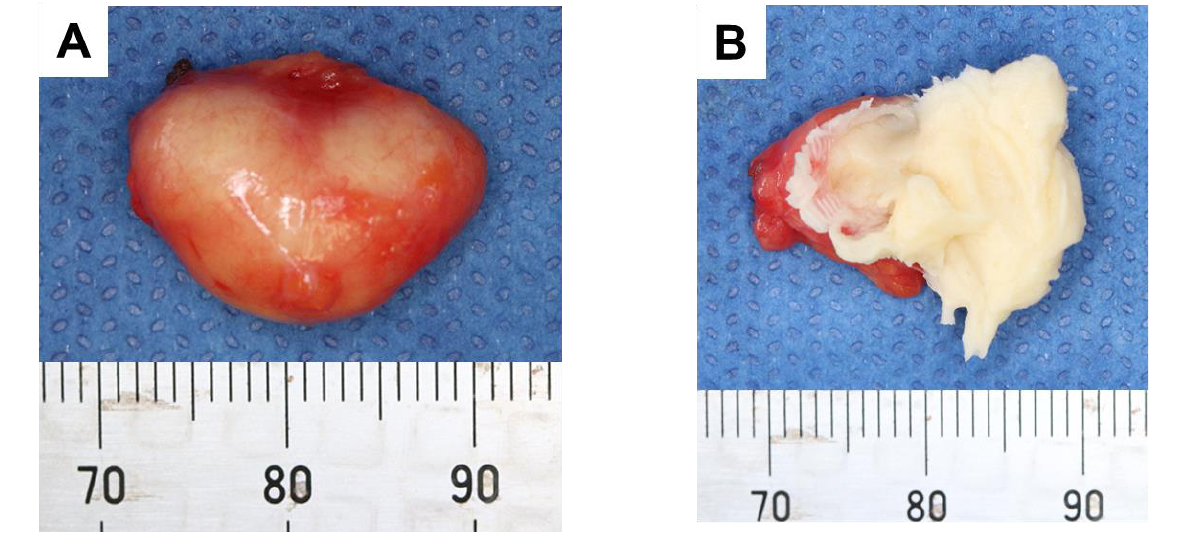
Figure 4. Macroscopic characteristics of cyst. ( A ) After removal. ( B ) Contents of cyst after splitting.